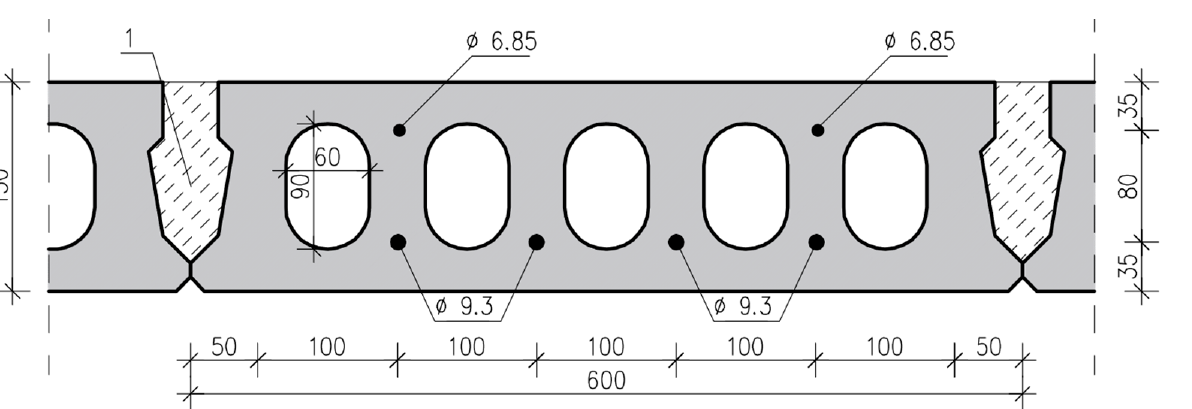
Figure 8. Cross-section of the slab with HC panel: 1—shear key.